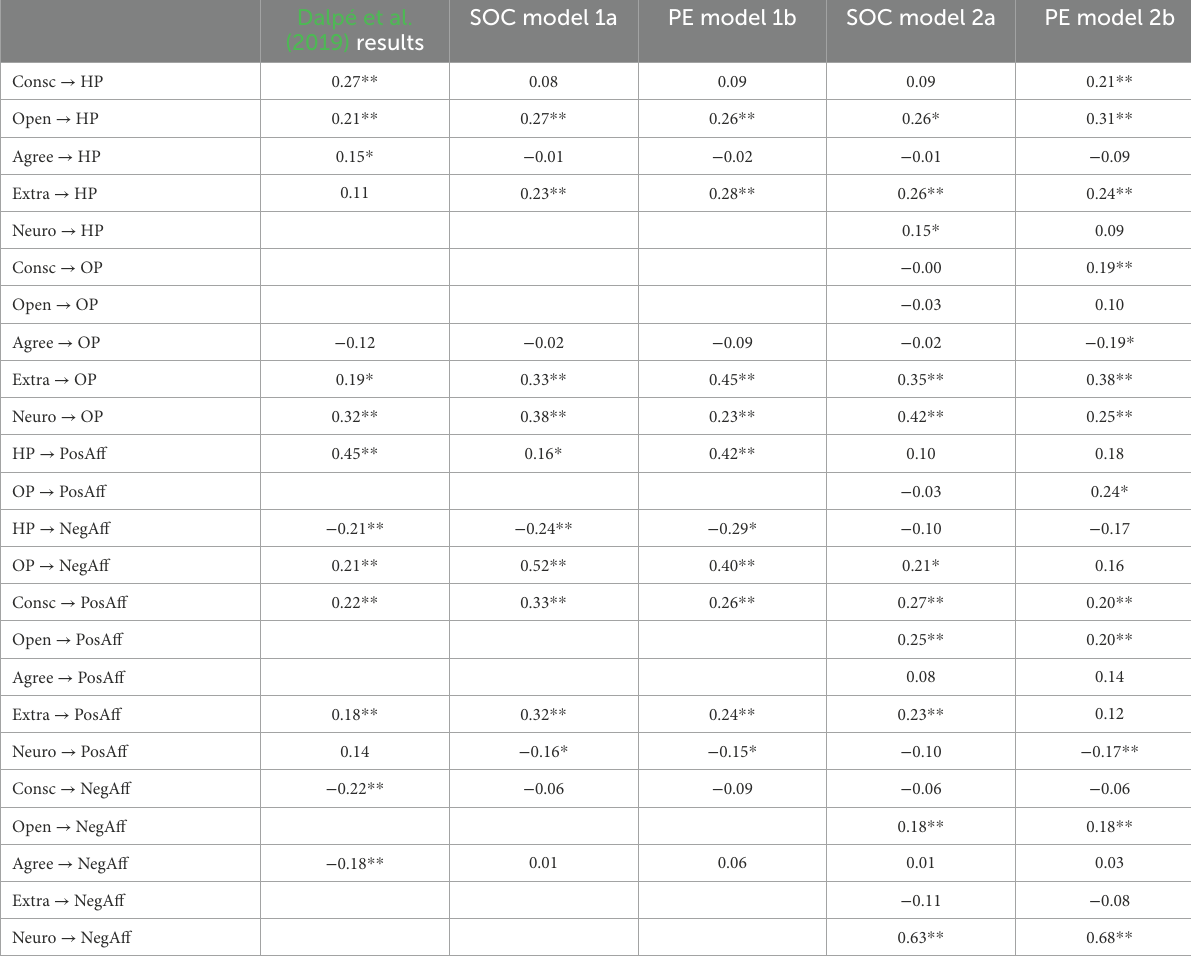
TABLE 1 Standardized path coefficients for SEM models of the relationship between personality, passions, and affect for social media and exercise. Dalpé et al. (2019)